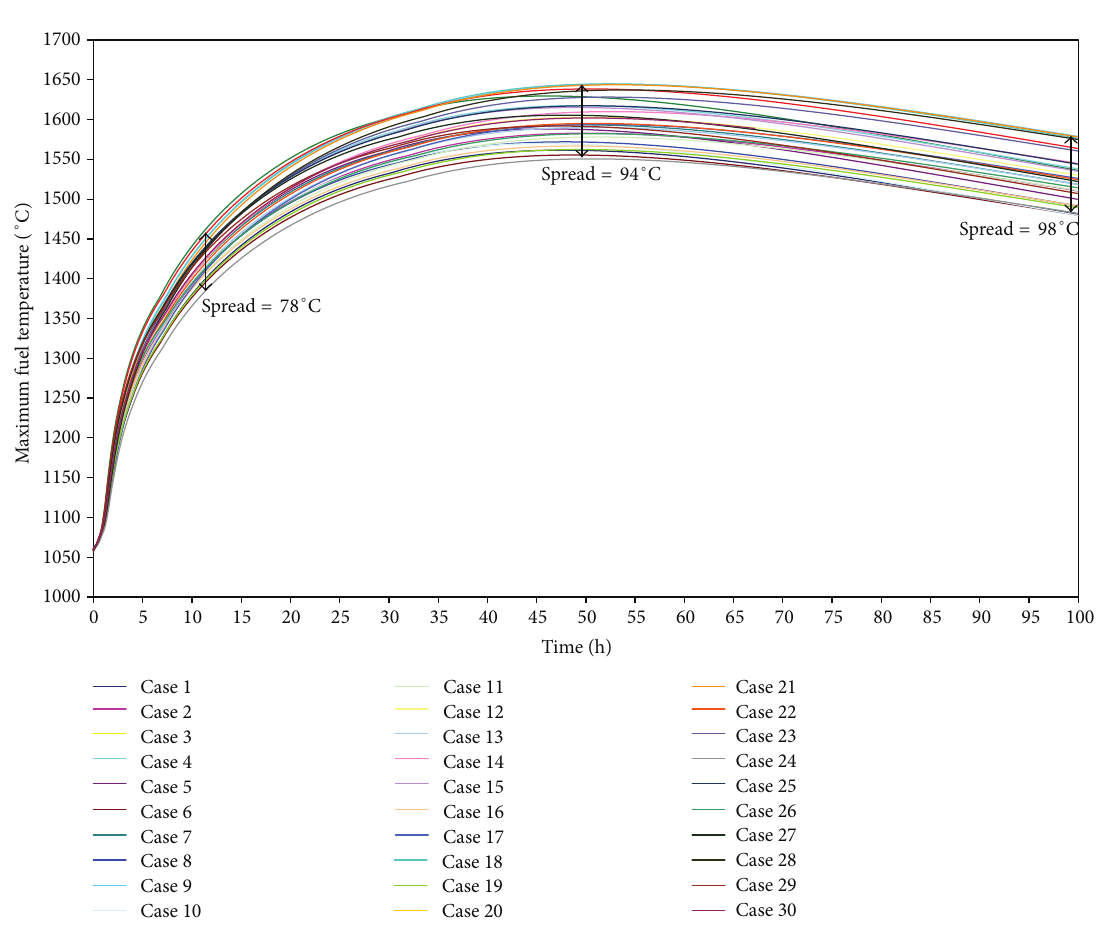
the DL�F� F�M. ese �ve input variables, together